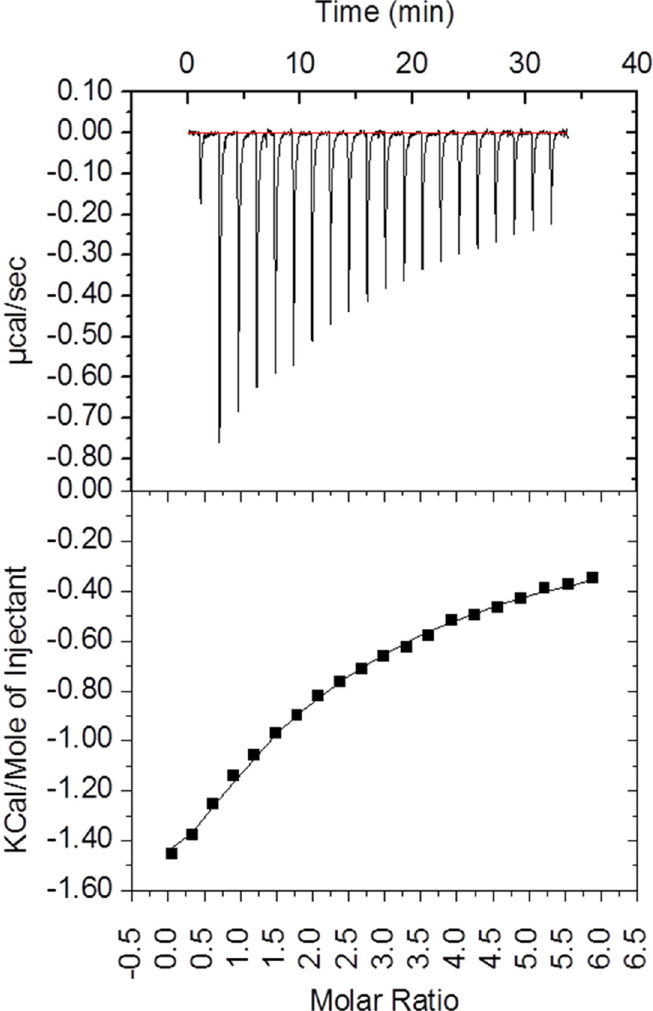
Fig 2. Binding interaction between CBEL and cellohexaose as investigated by isothermal titration calorimetry (ITC). The upper panel shows the thermogram representing the heat of binding. The lower panel shows the titration curve. Fitting procedure was performed using a two sequential binding site